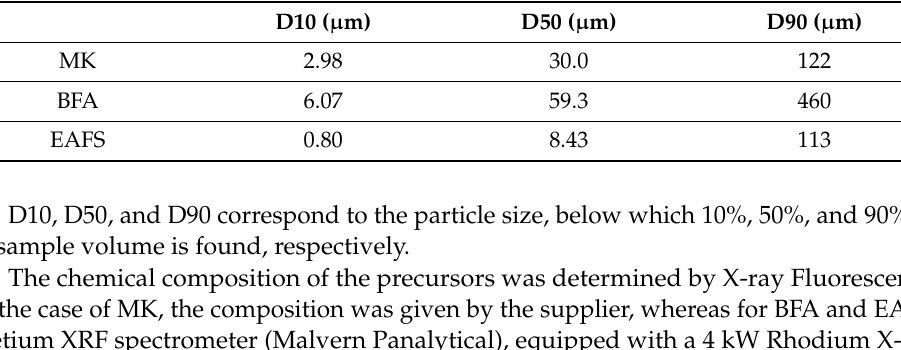
Figure 2. Cumulative PSD curves for GPC precursors. Table 1. PSD D10, D50, and D90 parameters for GPC precursors.